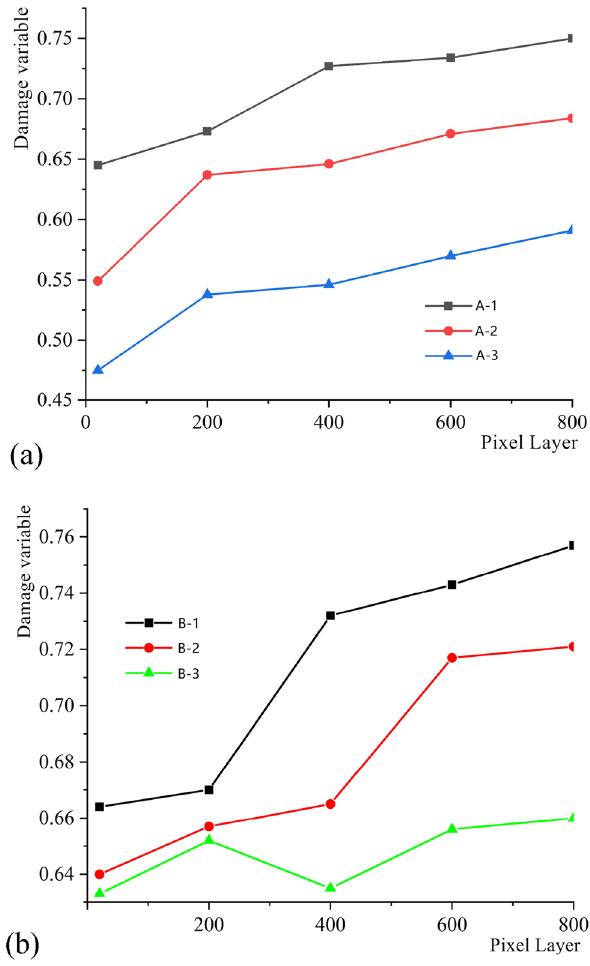
Figure 7: Damage variables under di ff erent experimental conditions. ( a ) Conventional triaxial test and ( b ) triaxial compression test with step